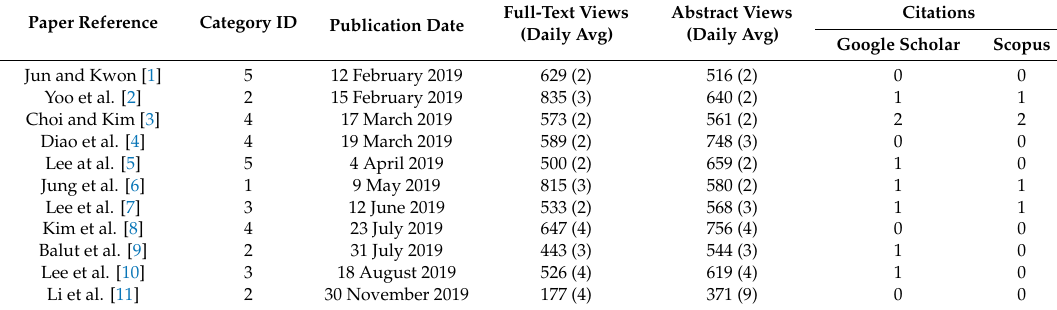
Table 1. Metrics of papers published in this Special Issue (cumulative full-text and abstract views were calculated until 12 January